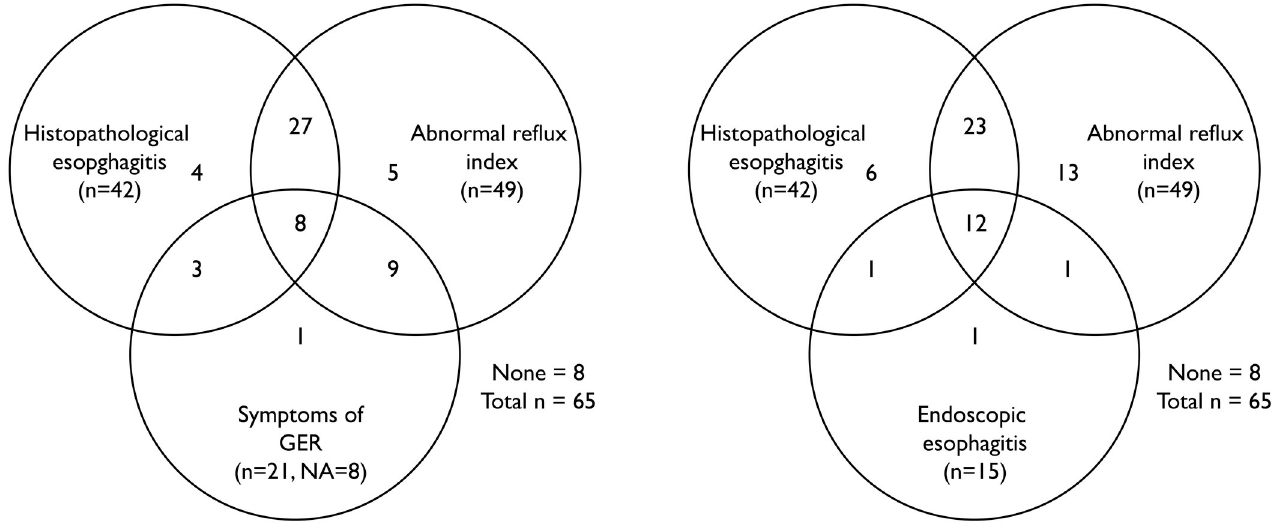
Fig 2. Venn diagram showing the overlap of patients regarding the variables included in logistic regressions. The numbers in each section represent the number of patients that present the particular variable, for overlapping sections the patient presents all the overlapping variables (please note that the size of the section does not correspond to the number of patients presenting the